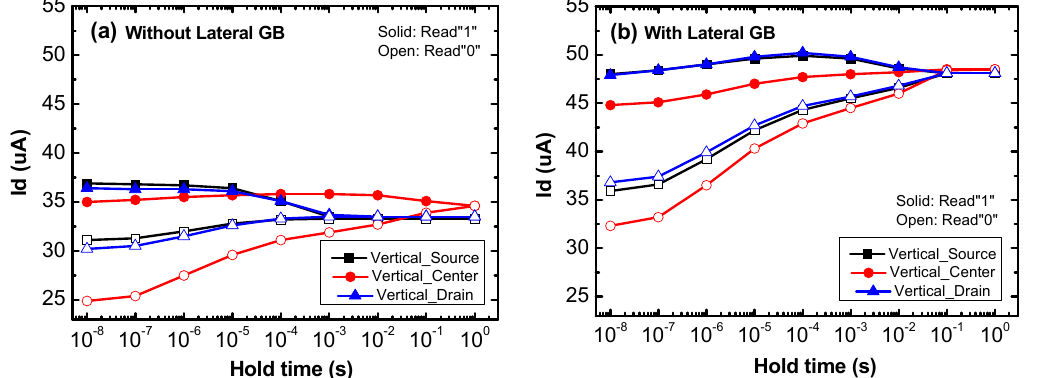
Figure 6. The retention characteristics of a poly-Si 1T-DRAM ( a ) without a lateral GB and ( b ) with a lateral GB according to a vertical GB’s location.